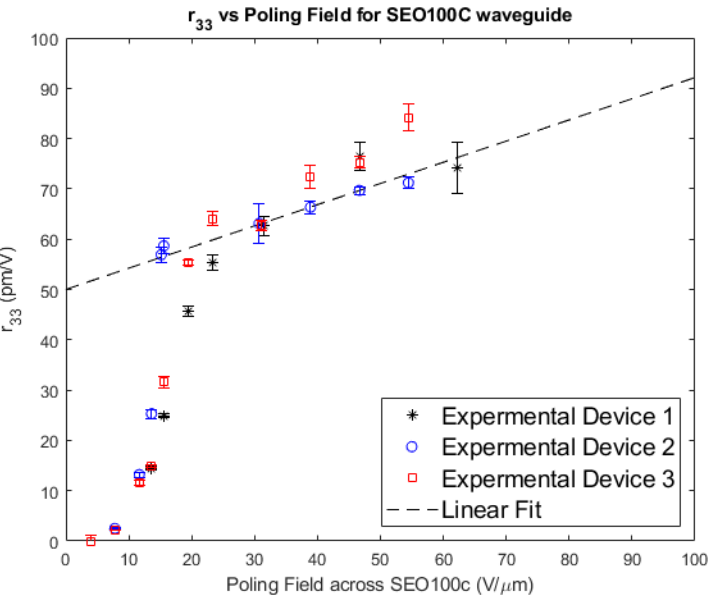
Figure 6. Measured r 33 for various polling field strengths. The dotted line shows a best fit linear line for poling fields greater than 20 V/ μ m across the core EO layer, with a slope of 0.37 pm/ μ